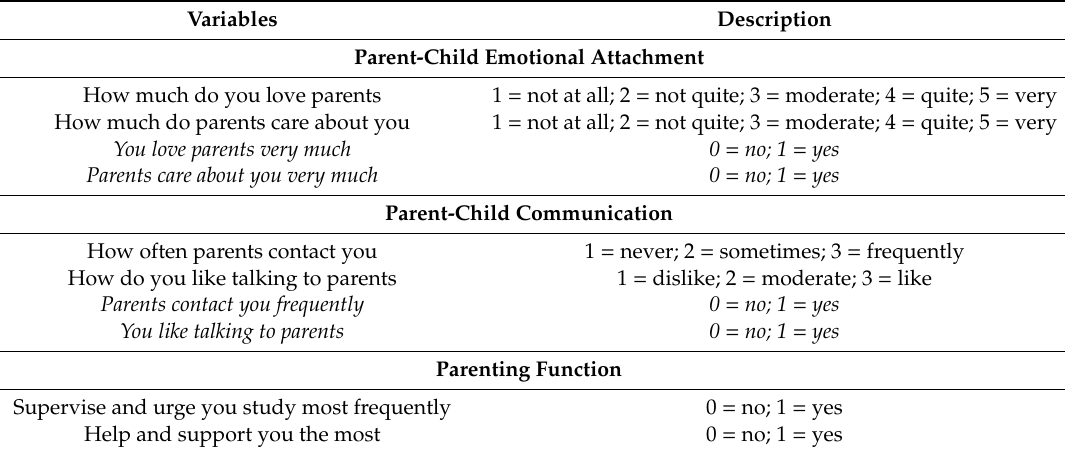
Table 3. Measurement of parent-child relation